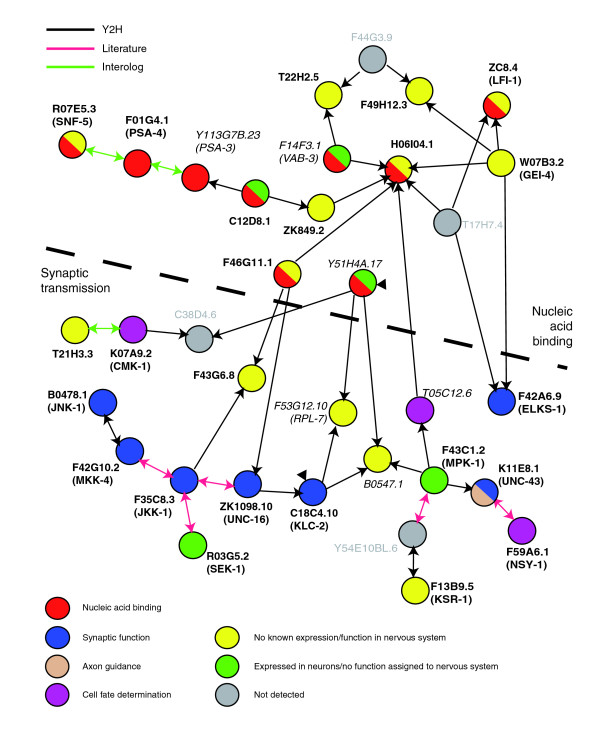
Interactome map of pan-neural genes. The C. elegans interactome contains functional and physical interactions for over 5,000 proteins. A comparison to the 711 transcripts enriched in both embryonic pan-neural (EP) and larval pan-neural (LP) datasets (see Figure 8) revealed a single large interaction cluster (see Materials and methods). Bold lettering denotes enriched transcripts and italics marks EGs detected in at least one of the pan-neural datasets. Gray letters refer to transcripts not found in either dataset. Black lines represent interactions isolated by yeast two-hybrid assay, red lines depict known interactions listed in worm Proteome Database (literature), and green lines denote in silico searches against orthologous pairs (interolog). Black arrows point from bait to prey. Arrowheads indicate self-interactions. Protein functions are denoted with colored circles (see key at bottom). The dashed black line demarcates two subgroups of interacting proteins, nucleic acid binding (above) versus synaptic transmission (below). See text for additional information.